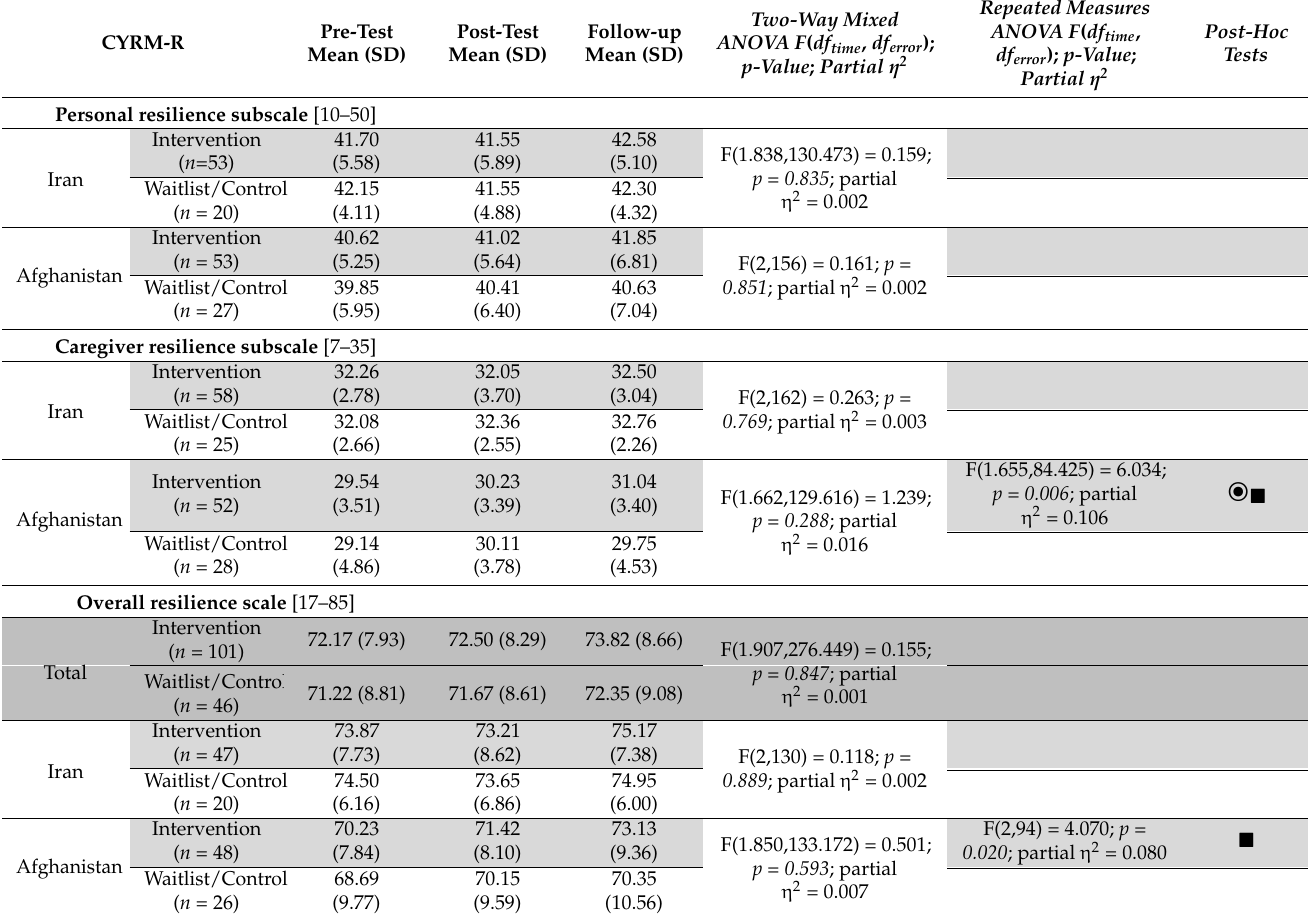
Table 2. Mean CYRM-R scores over time for families overall and originating from Iran or Afghanistan by intervention or waitlist/control group ( higher scores indicating a higher levels of resilience ).